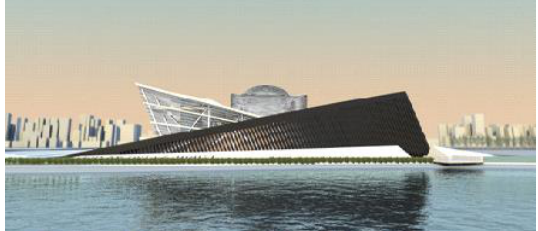
Fig. 7: Opera house (competition). (Greek architects, 2012)